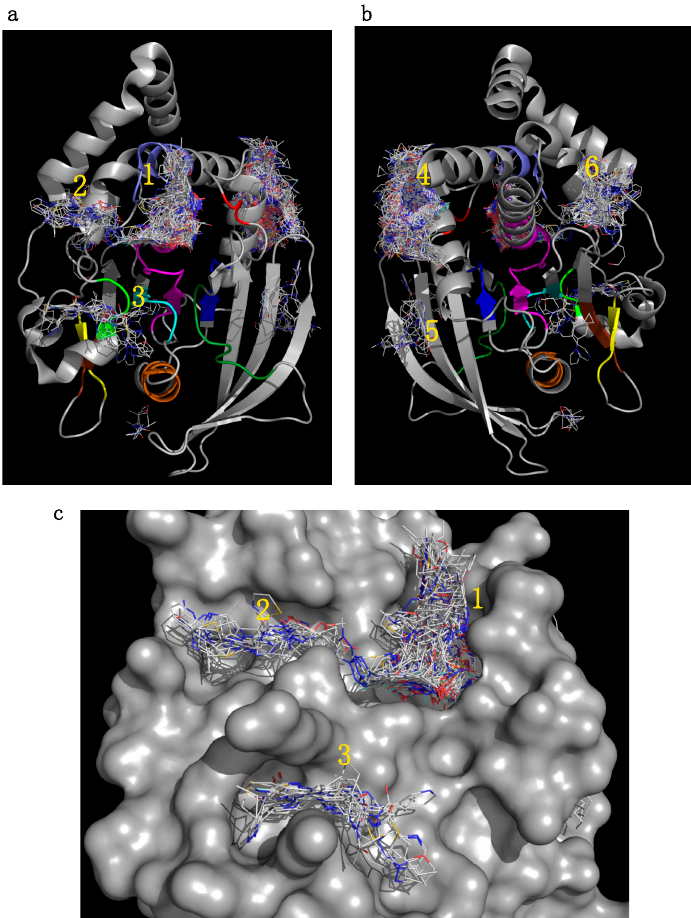
Figure 2. Blind docking results for PTP1B. The structure of PTP1B is shown as a grey cartoon, front view on ( a ) and back view on ( b ). Compounds are shown as lines. Areas where there is a high density of compounds (greater than 10) are classified as clusters and numbered: (1) active site, (2) secondary pTyr site, (3) centred on L41 (4) allosteric binding site (5) centred on V155 and (6) centred on E252. Key functional regions [24] have been coloured on the PTP1B structure, Motif 1 in green, Motif 2 in yellow, Motif 3 in brown, Motif 4 in cyan, Motif 5 in orange, Motif 6 in blue, Motif 7 in dark green, Motif 8 in red, Motif 9 in magenta and Motif 10 in purple; ( c ) Blind docking successfully identified the active site (1) and surrounding key sub-pockets including the secondary pTyr site (2) and the site around motif 1 (3). Compounds in the clusters are shown as lines whilst PTP1B shown as grey surface.